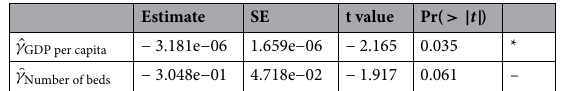
Table 5. Regression coefficient estimation and significance